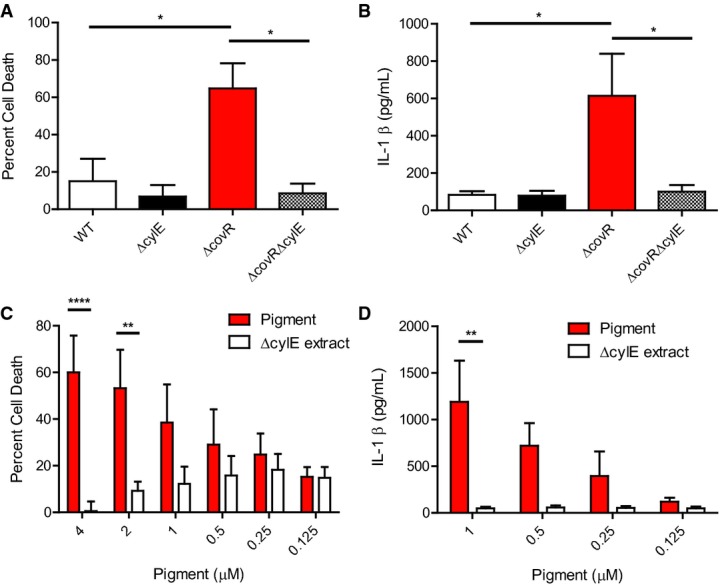
The GBS pigment toxin/lipid toxin is pro-inflammatory and cytotoxic to primary human macrophages
A, B PBMC-derived macrophages were treated with GBS WT, ΔcylE, ΔcovR, or ΔcovRΔcylE at an MOI of 1 and incubated for 4 h. Cytotoxicity was measured by LDH release (A), and IL1β release in supernatants was measured by ELISA (B).

C, D PBMC-derived macrophages primed with 100 ng/ml LPS for 3 h were incubated with various concentrations of GBS pigment or control ΔcylE extract for 4 h. Cytotoxicity was measured by alamar blue assay (C), and IL1β release from pigment- or ΔcylE extract-treated cells was measured by Luminex assay (D).Data information: Data shown are the average of four independent experiments performed in triplicate, error bars ± SEM. Significance was determined using Bonferroni's multiple comparison test following ANOVA. (A) n = 4, *P = 0.021 for WT versus ΔcovR; *P = 0.01 for ΔcovR versus ΔcovRΔcylE. (B) n = 4, *P = 0.031 for WT versus ΔcovR; *P = 0.036 for ΔcovR versus ΔcovRΔcylE. (C) n = 4, ****P < 0.0001, **P = 0.002. (D) n = 4, **P = 0.005.